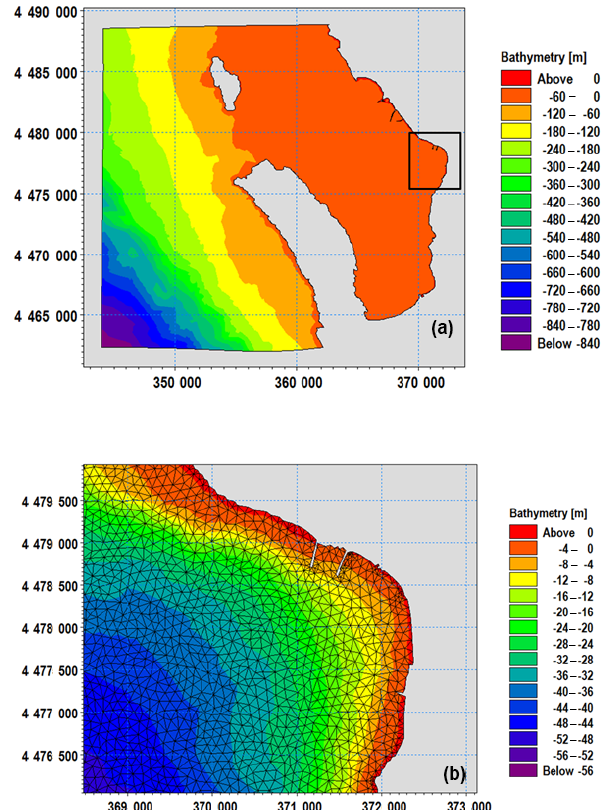
Figure 4. Bathymetry of the wave model (a) and close-up of the bathymetry and mesh at the harbour entrance area (b) .